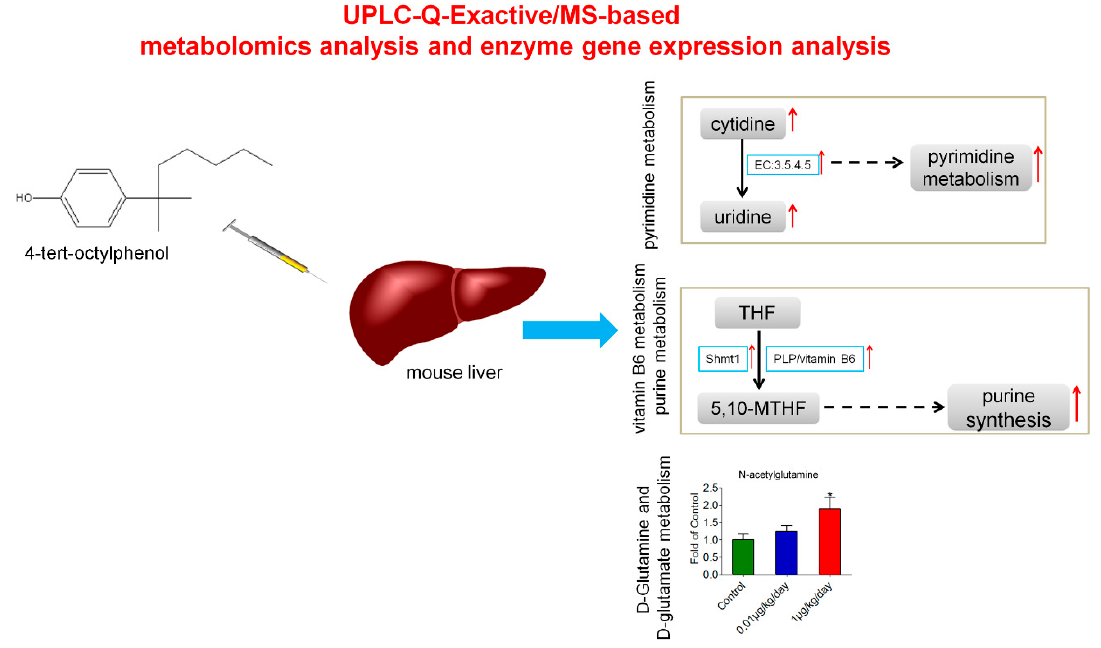
Figure 7. Summary of the integrated metabolomic and enzyme gene expression analysis of mice liver treated with low-dose OP.